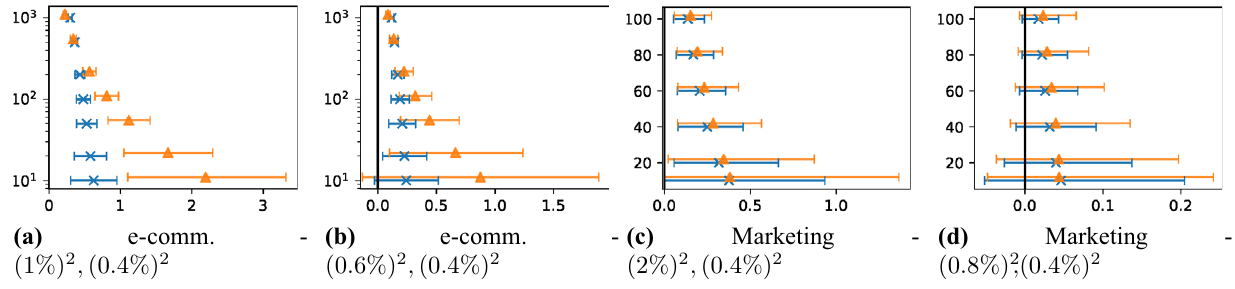
Fig. 8 The value gained by having some experimentation and meas- urement (E&M) capabilities ( x -axes, in percent) under normal assumptions (blue error bars with crosses) and t -distributed assump- tions (orange error bars with triangles). Both assumptions are evalu-